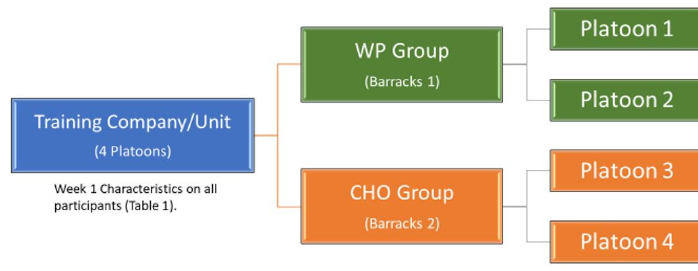
Figure 1. Grouping of the participants. WP: whey protein and CHO: carbohydrate.